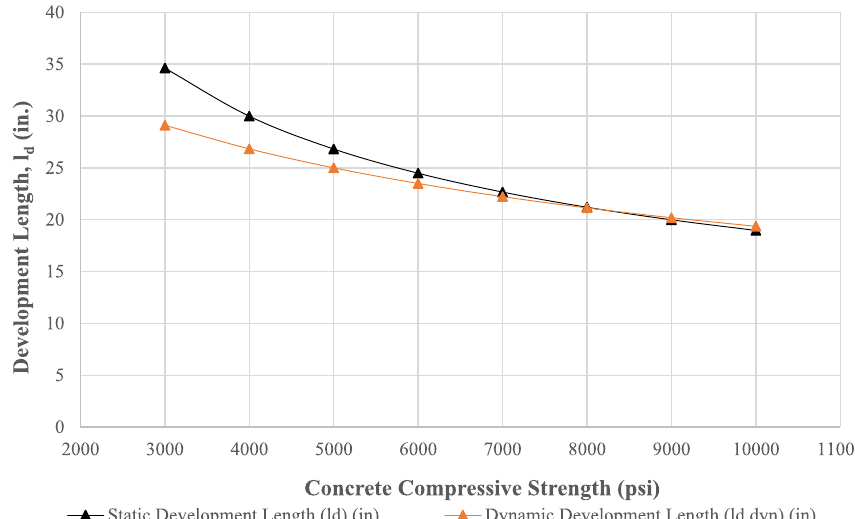
Fig. 9 Development length at increasing compressive